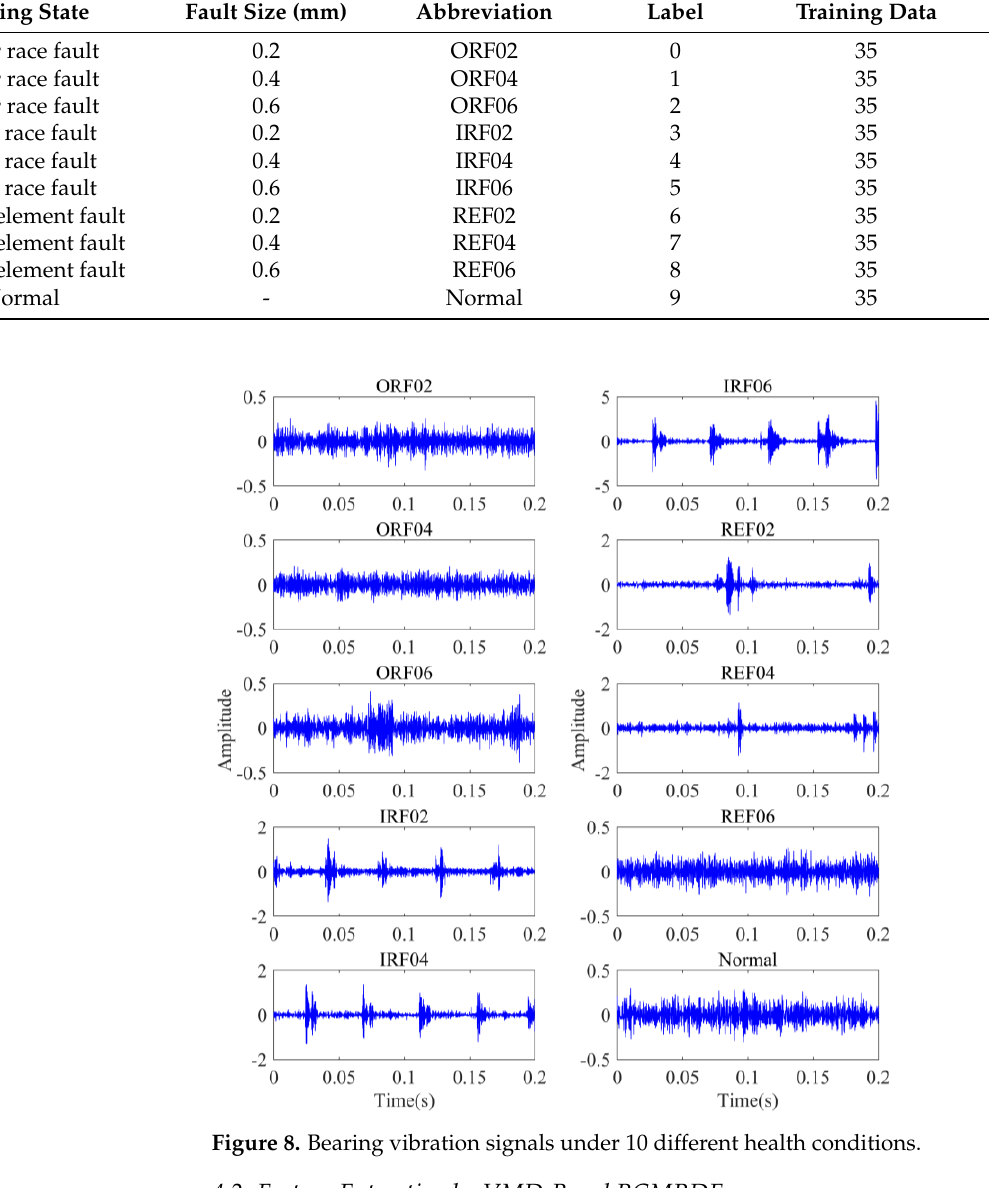
( b ) Figure 9. The frequency spectrum of normal bearing signal: ( a ) spectrum of original signal; ( b ) spec- trum of each component.